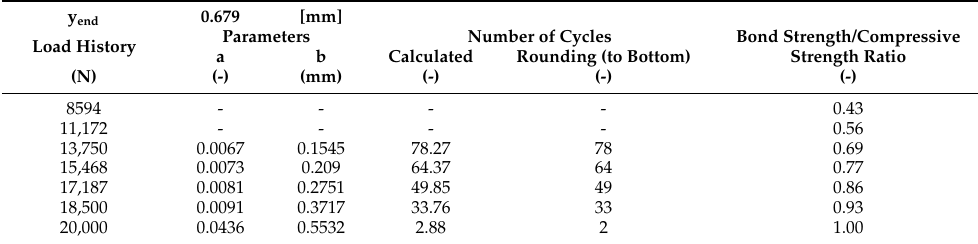
Table 9. Parameters of the lines and the approximated number of cycles in case of LWAC.